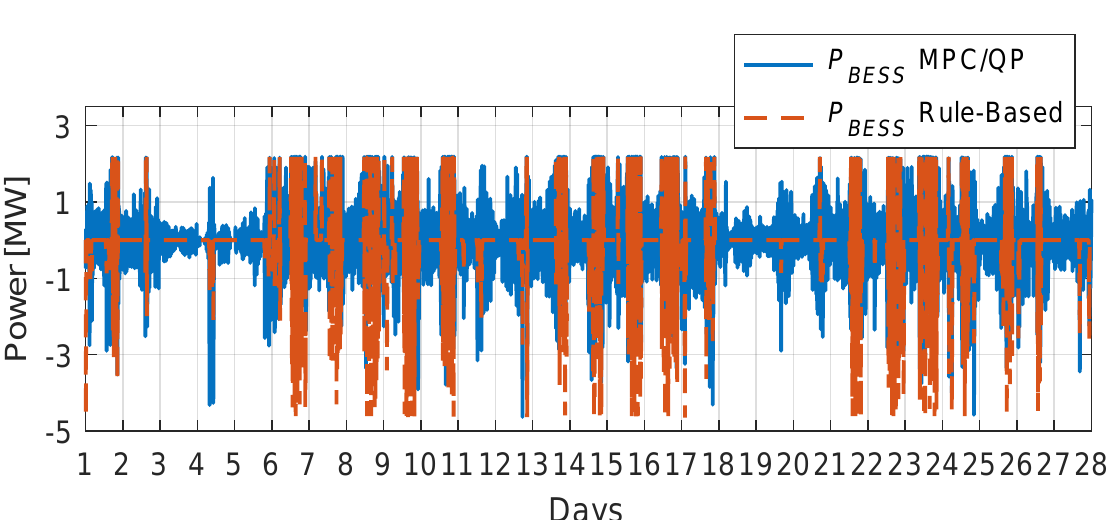
Figure 30. MPC/QP and rule-based algorithms: storage system power with λ 1 = λ 2 = 50, commitment with maximum 10% error, initial SoC of 50%, and 50% as SoC set-point.